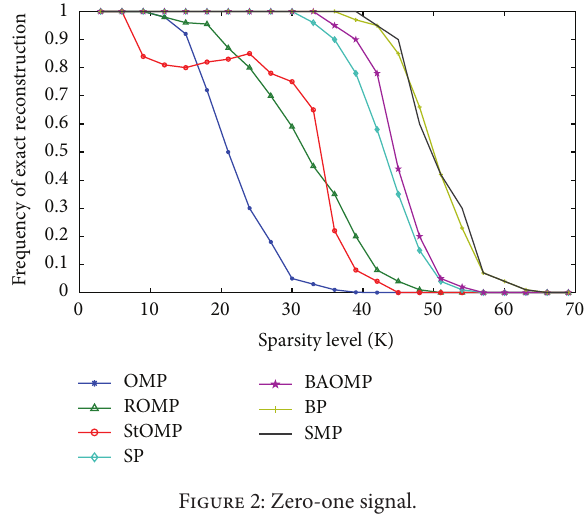
Figure 2: Zero-one signal.